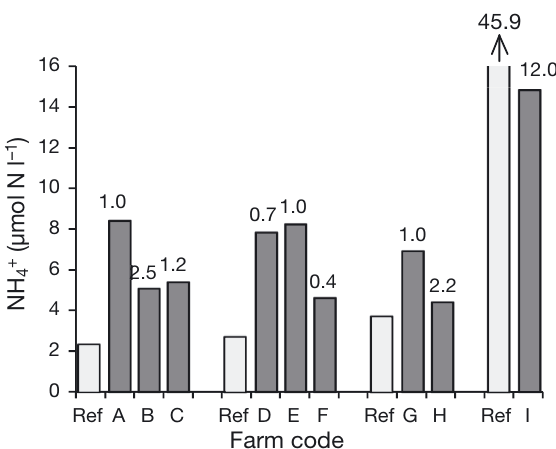
Fig. 4. Median total ammonium (NH 4+ ) concentrations for ef- fluents of south coast (A−F) and west coast abalone ( Haliotis midae) farms (G−I) compared with the 80 th percentile (Ref). South coast farms are presented separately for Hermanus (A−C) and Gansbaai (D−F). Farm I was operating on partial recirculation. The numbers above the dark grey bars are the median absolute deviation. The arrow indicates